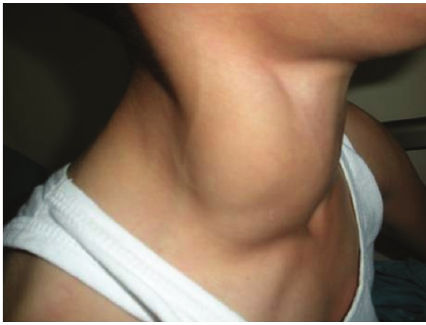
Figure 2: The mass increased in size and became visible with the valsalva maneuver.